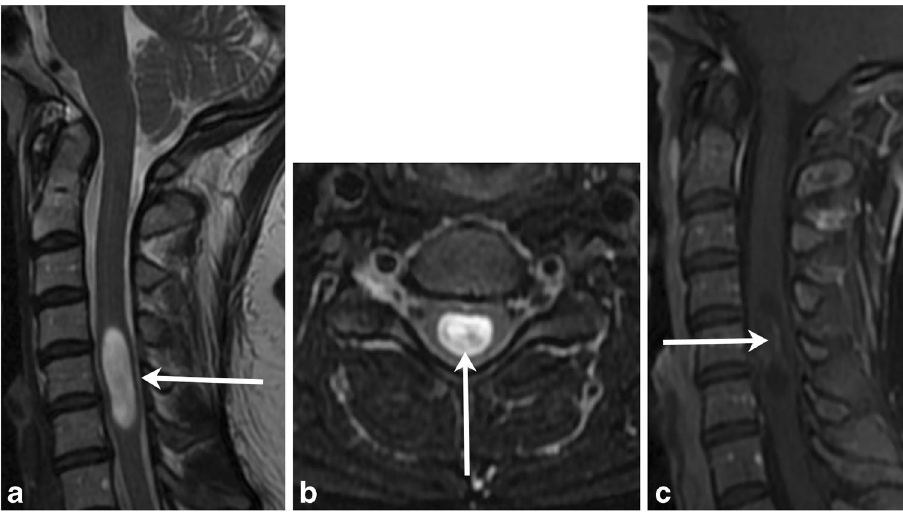
Fig. 13 Ependymoma. A 38- year-old female with pulse-like sensation in both hands. a and b T2 hyperintense mass (arrow) in- volves more than two vertebral body levels within the central cord. c Minimal heterogeneous enhancement (arrow) on the T1 post-contrast image